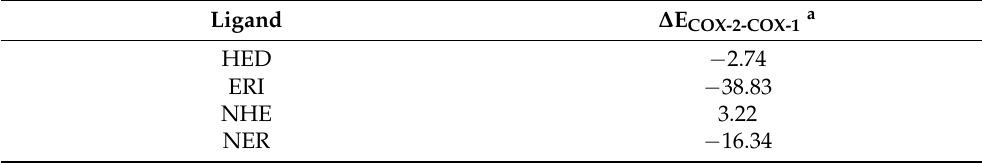
Table 4. Difference in interaction energies for each ligand between COX-2 and COX-1.